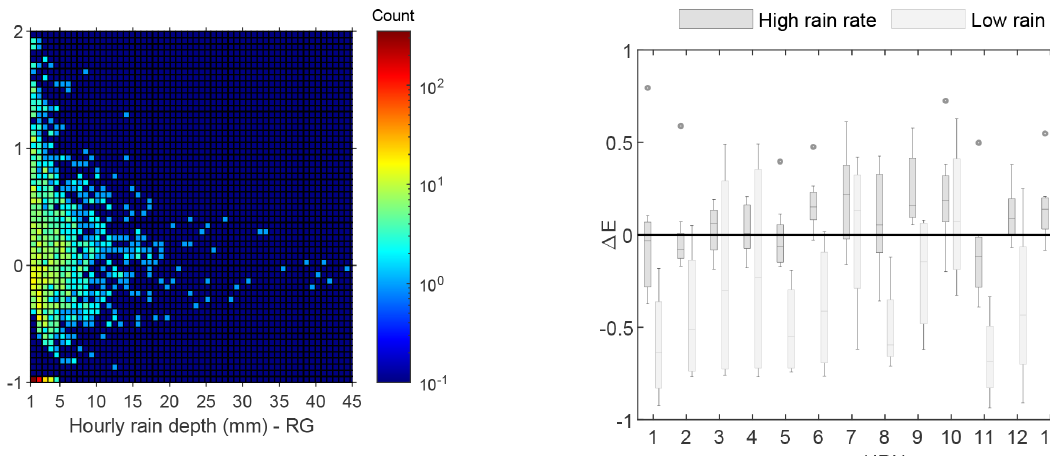
Figure 7. A 2D histogram of hourly rainfall depth from RGs and (cid:49)E . The colour of each equally spaced 2D bin represents its height, which is the count of data falling in the bin. The scale bar has a logarithmic scale, and the dark-blue bins correspond to zero counts. Values of (cid:49)E equal to − 1 represent false negatives.